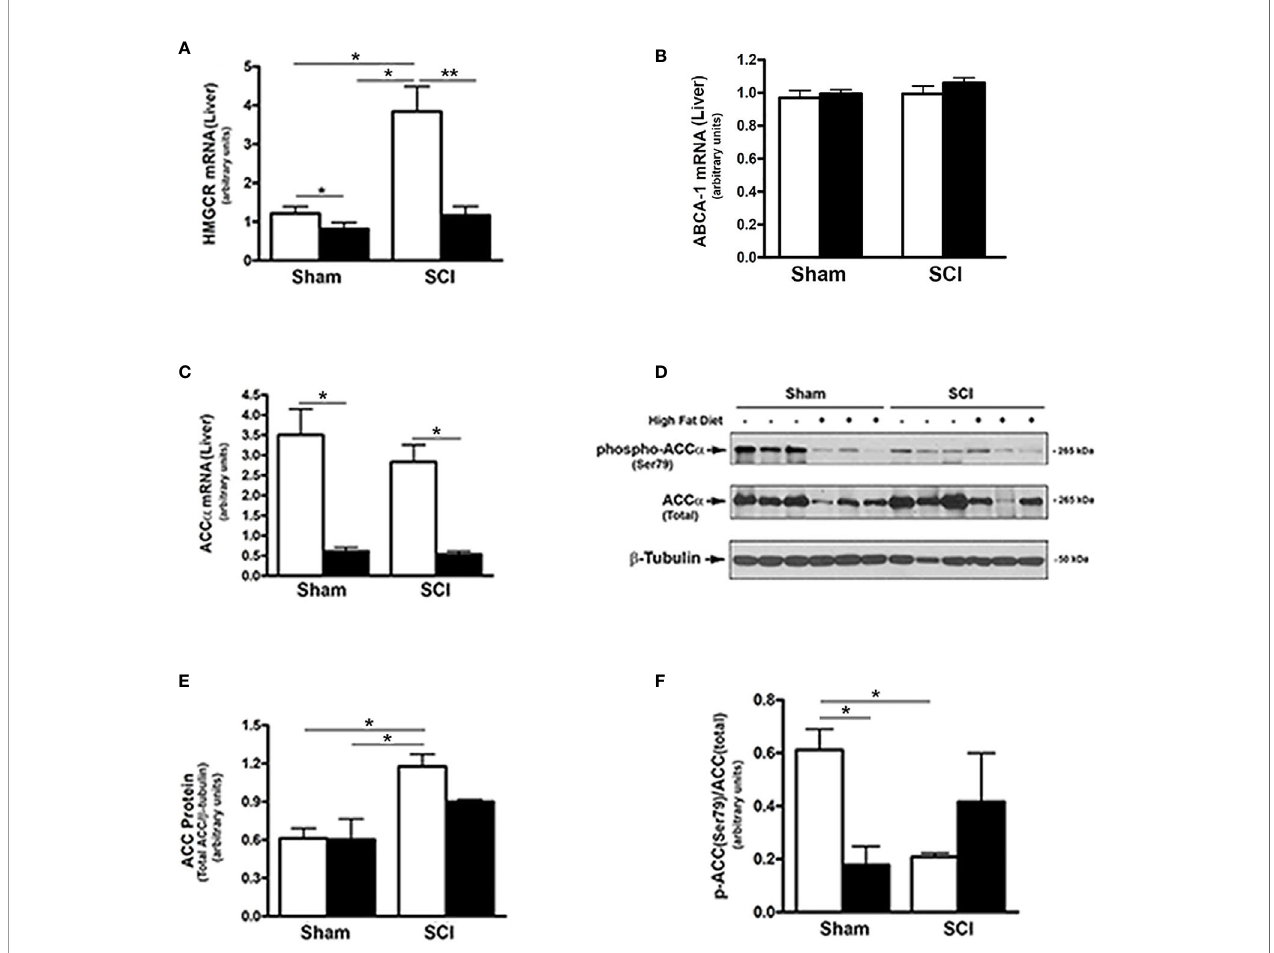
FIGURE 4 | Effects of SCI and HFD on Metabolic Gene Expression in Mouse Liver. Mice were fed with either ConD (White Bar) or HFD (Black Bar) after surgery. Total RNA was isolated from mouse liver and subjected to Rt-PCR analysis for (A) , HMGCR mRNA; (B) , ABCA1 mRNA; (C) , ACC a mRNA; (D) , total protein lysates were extracted from mouse liver and subjected to Western blot analysis using anti-ACC a (endogenous) or anti-phospho-ACC a (T172) antibodies; (E) , blots were quanti fi ed by scanning densitometry and blots in the middle panel of (D) were normalized relative to b -tubulin (lower panel); (F) , blots in (D) (upper panel) were normalized relative to endogenous (total) ACC a protein (middle panel). Data shown are means values ± SEM (n = 5). Data shown in (C) are representative Western blots. * p < 0.05, ** p <